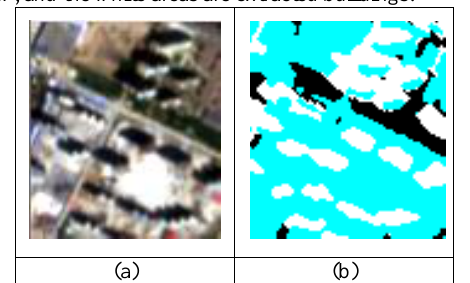
Figure 13. An example of building extraction result (a) original image; (b) building extraction result